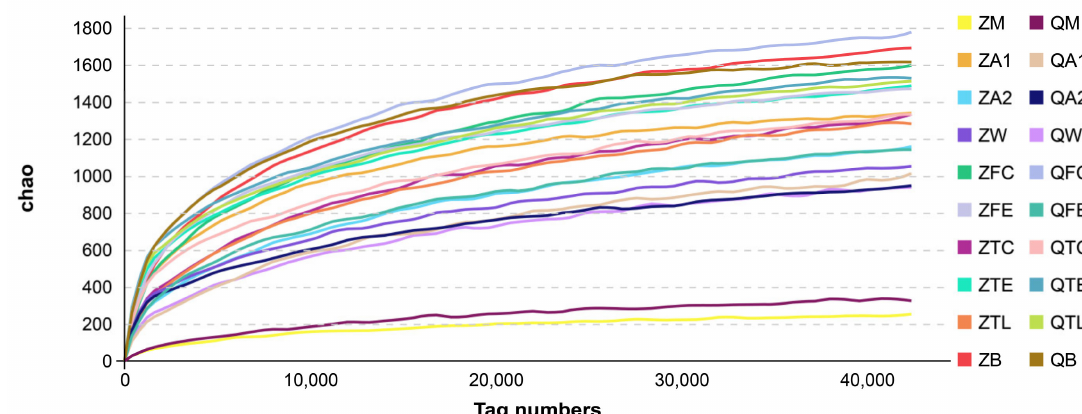
Figure 1. High-throughput sequencing quality control and bacteria alpha diversity indices. ZM: milk samples at Zhengzhou farm, QM: milk samples at Qiqihar farm, ZA1: dairy hall air samples at Zhengzhou farm, QA1: dairy hall air samples at Qiqihar farm, ZA2: cowshed air samples at Zhengzhou farm, QA2: cowshed air samples at Qiqihar farm, ZW: cow trough water samples at Zhengzhou farm; QW: cow trough water samples at Qiqihar farm, ZFC: feces samples at Zhengzhou farm, QFC: feces samples at Qiqihar farm, ZFE: feed samples at Zhengzhou farm, QFE: feed samples at Qiqihar farm, ZTC: teat dip cup samples at Zhengzhou farm, QTC: teat dip cup samples at Qiqihar farm, ZTE: teat samples at Zhengzhou farm, QTE: teat samples at Qiqihar farm, ZTL: teat liner samples at Zhengzhou farm, QTL: teat liner samples at Qiqihar farm, ZB: bedding samples at Zhengzhou farm, QB: bedding samples at Qiqihar